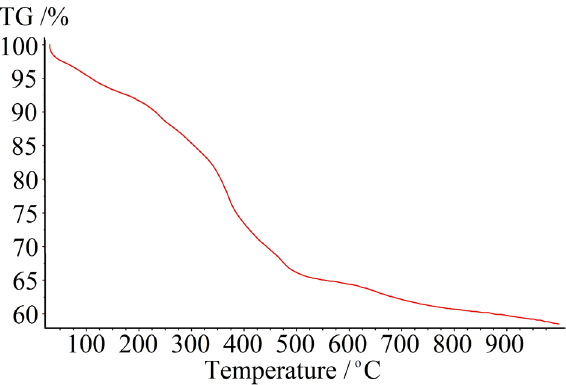
Figure 5. TGA/DTA diagrams of Cu(II)-MP-bis(AMP)@boehmite.